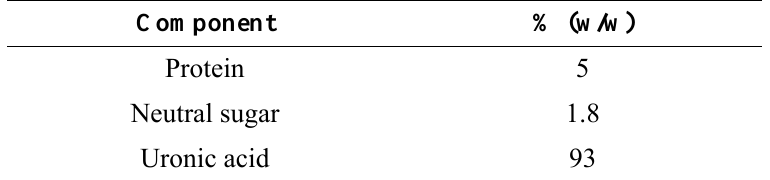
Table 2. Percentage composition of purified bioflocculant produced by Cobetia sp.